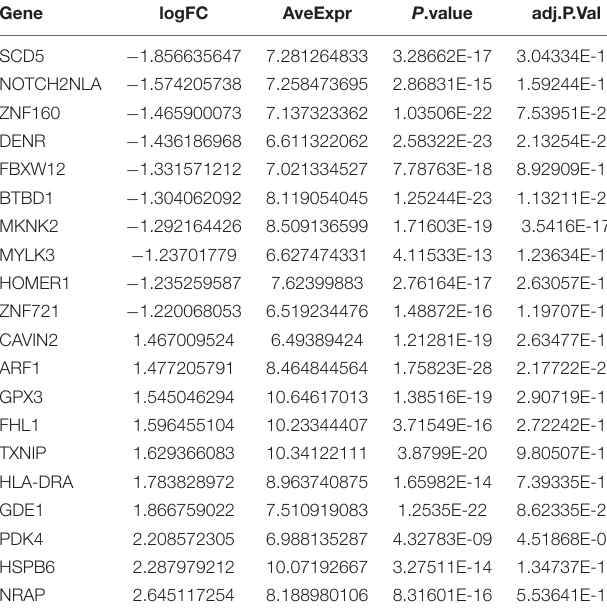
TABLE 4 | Top 10 upregulated and downregulated genes between cluster 2 and cluster 3 are